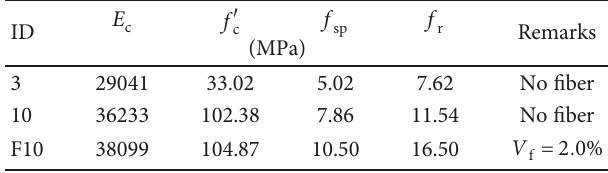
Table 4: Mechanical properties of concrete.